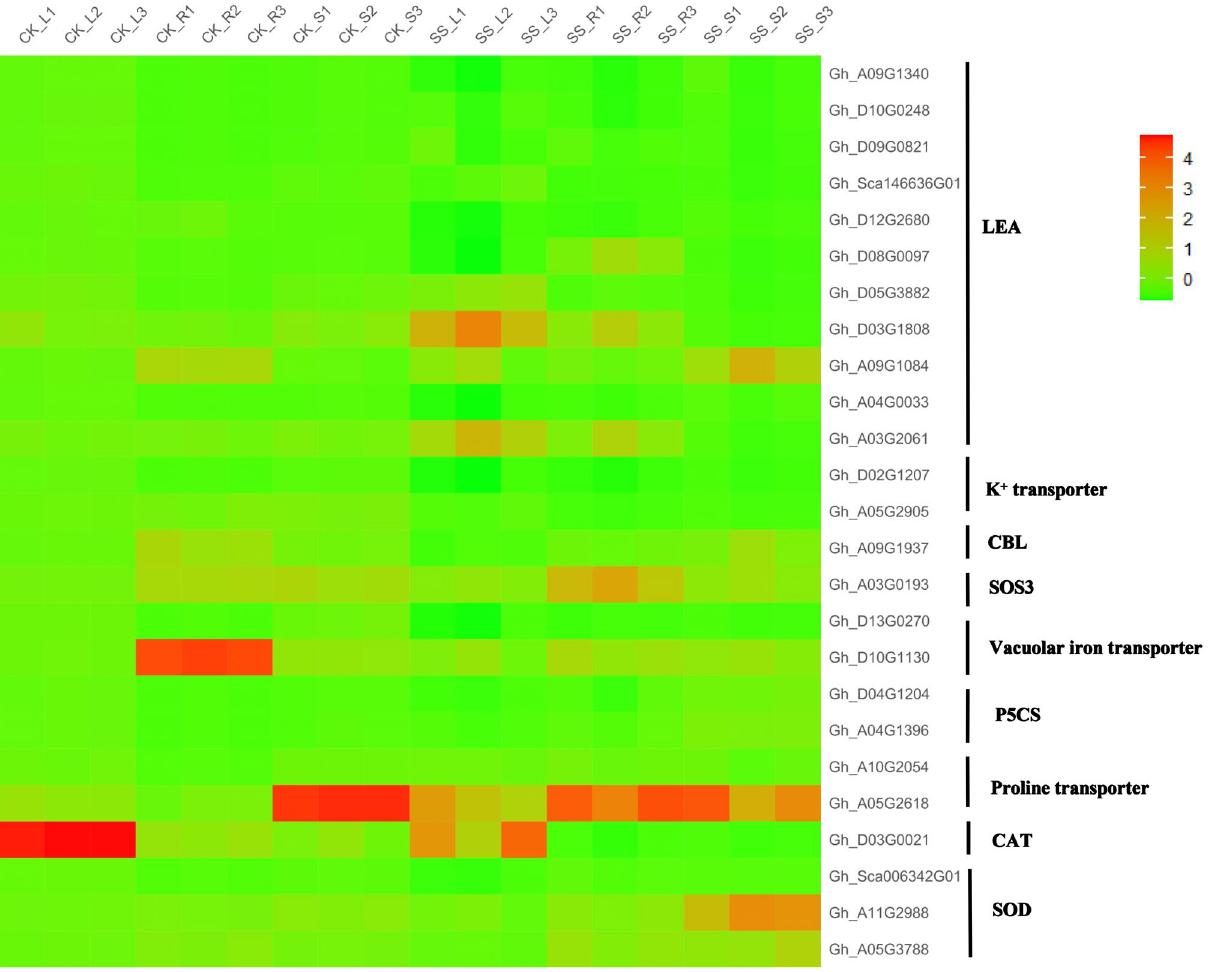
Figure 9. Heatmap of the standardized FPKM expression level of the DEGs related to ionic homeostasis enrichment among roots, stems and leaves between SS and CK performed by ggplot2 (v3.3.3). CK: Control group; SS: 300 mM Na 2 SO 4 . Red = high expression level of genes, and Green = low expression level of